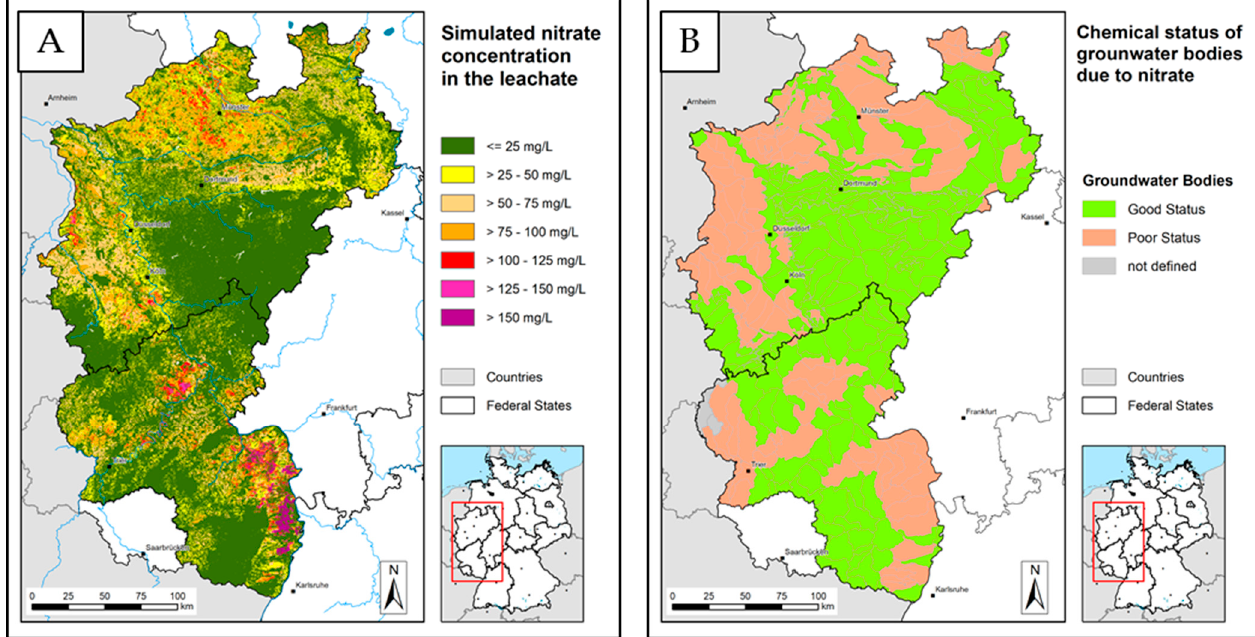
Figure 3. Mean long-term nitrate concentration in the leachate ( A ) and chemical status of groundwater bodies due to nitrate (status according to the EU Water Framework Directive ( B ): good status: <50 mg NO 3 /L, poor status >50 NO 3 mg/L.